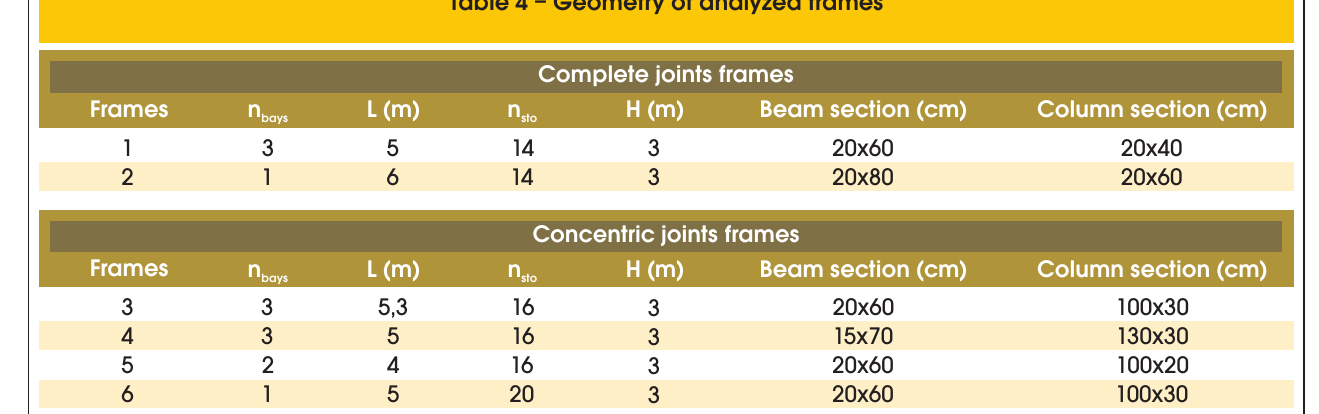
Table 4 – Geometry of analyzed frames